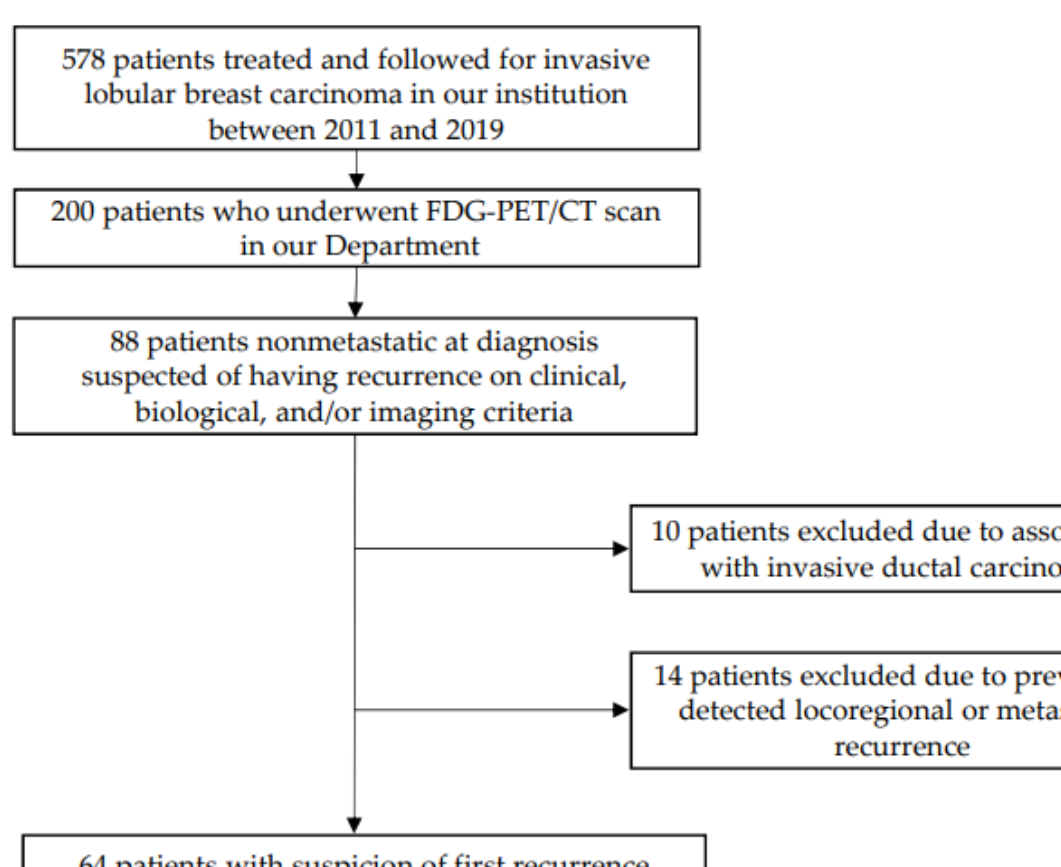
Figure 1. Flowchart of the study population. FDG-PET/CT: Positron Emission Tomography/Computed Tomography using 2-deoxy-2- [18F]fluoro-D-glucose